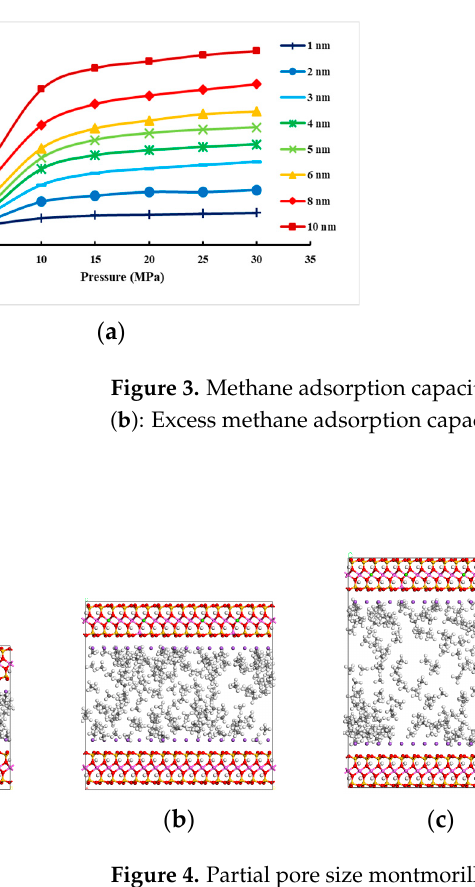
( b ) Figure 5. Methane adsorption capacity at different pore sizes ( a ): Total methane adsorption capac- ity, ( b ): Excess methane adsorption capacity. (3) Density variation under different pore sizes of montmorillonite slit Figure 6 shows the density comparison of CH 4 under different pore sizes of the montmorillonite slit. It can be found in Figure 6 that the peak of CH 4 density distribution is located near the wall of the montmorillonite slit. Moreover, when the width of the ox- idized montmorillonite slit pore size is 1 nm, most of the CH 4 is attached to both sides of the slit and exists in the adsorption state. When the slit width is 2~5 nm, most of the CH 4 is still attached to the slit wall, but some of it is also dispersed in the pores in the middle of the slit. When the slit width is 6~10 nm, the density of CH 4 dispersed in the pores in- creases some more compared with 2~5 nm. Therefore, there are two occurrences of CH 4 in the slit of montmorillonite with different pore sizes. In the small pore size, CH 4 is mainly in the adsorbed state, and as the slit width increases, the free state of CH 4 be- comes more, and the two occurrences in the slit will coexist.